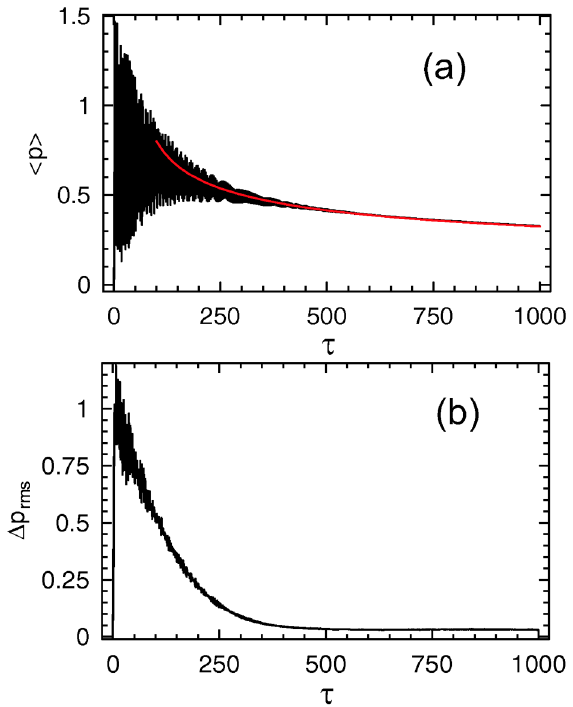
FIG. 4. (Color) Numerical simulation of the nonlinear regime of the instability: (a) the average momentum h p i ; (b) the rms . The red line shows the result of the momentum spread (cid:17) p rms analytical